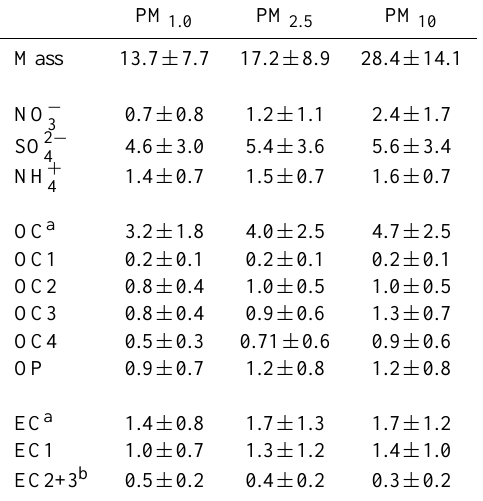
Table 2. Averaged concentrations of mass and major compositions of PM 1 . 0 , PM 2 . 5 , and PM 10 .